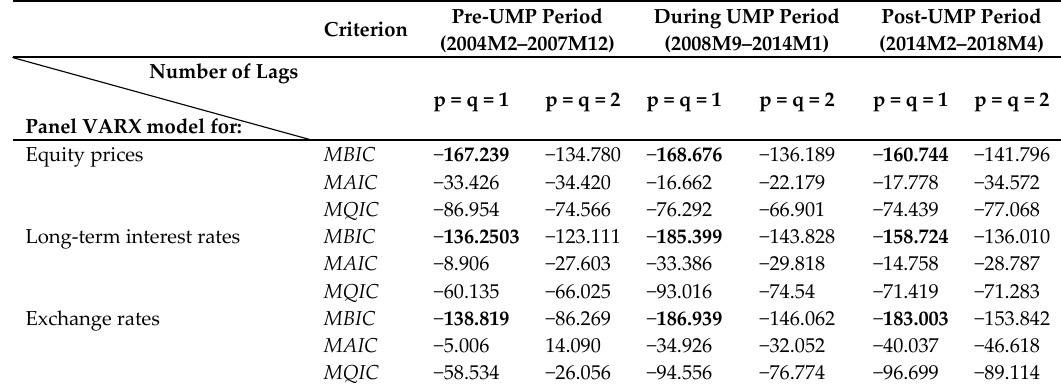
Table A2. Lag structure selection.